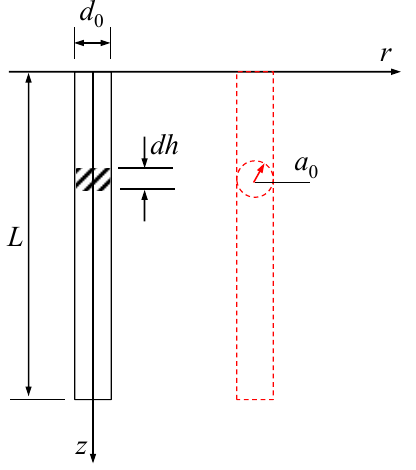
Figure 2. Equivalent simulation of static-pressure pile penetration.